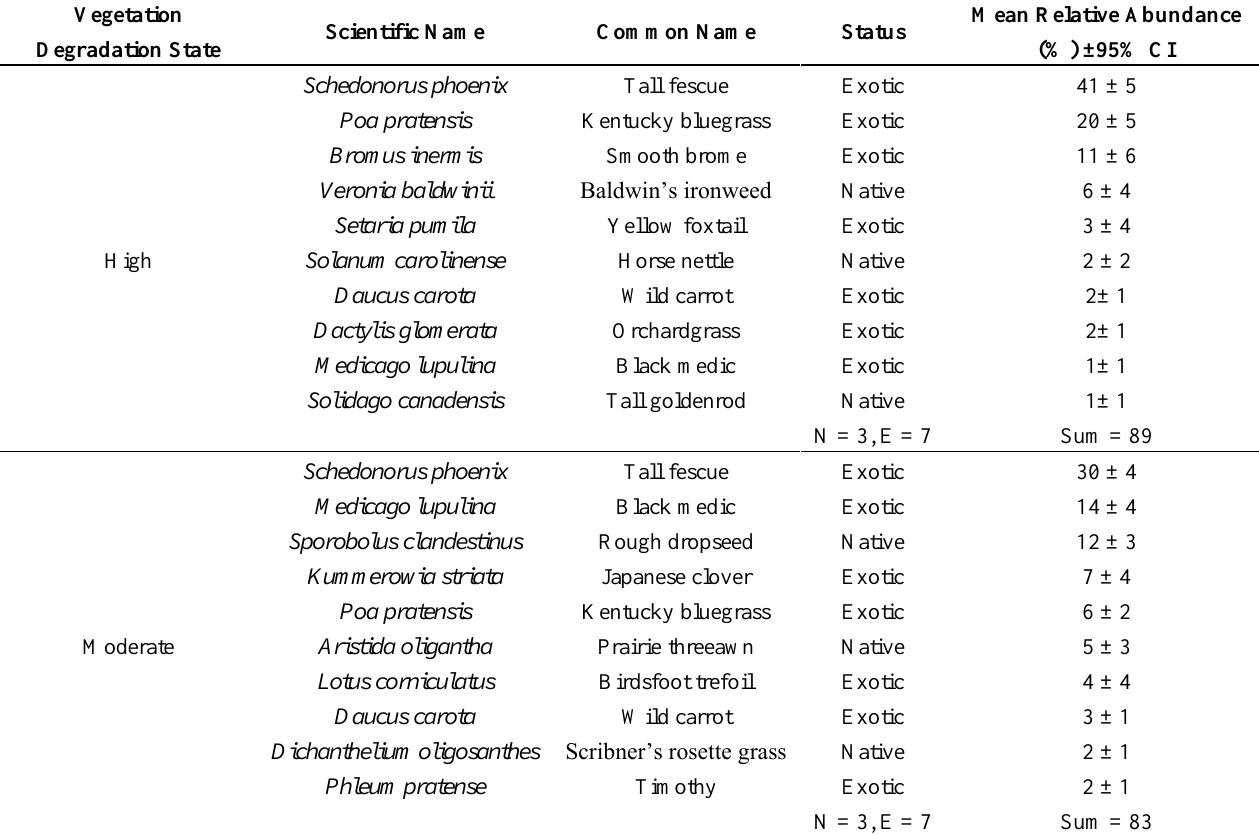
Table 1. Ten most abundant species (percent of total canopy cover) within each of three vegetation degradation states identified by hierarchical clustering of 196 plant species abundance sampled from nine tracts in the Grand River Grasslands of south-central Iowa and north-central Missouri,